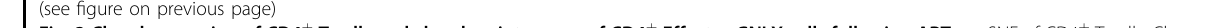
Fig. 3 Clonal expansion of CD4 + T cells and clonal maintenance of CD4 + Effector-GNLY cells following ART. a t -SNE of CD4 + T cells. Clusters are denoted by color labeled with inferred cell types (left) and TCR detection (right). Cells are colored the same in (Fig. 1b). b Bar plots showing the percent of TCR detection in each CD4 + T cell cluster. c The association between the number of CD4 + T cell clones and the number of cells per clonotype. The dashed line separates non-clonal and clonal cells, with the latter identi fi ed by repeated usage of TCRs. LOESS fi tting is labeled as the solid line showing a negative correlation between the two axes. d The distribution of the clone state of CD4 + T cells in each cluster across the three conditions. e Comparison between the fraction of clonal cells in each subset ( X -axis) and percentage of cells with TCRs shared across clusters ( Y -axis). f Developmental transition of CD4 + Effector-GNLY cells with other CD4 + cells quanti fi ed by pairwise STARTRAC-tran indices for each patient ( n = 14). *** P < 0.001, Permutation test. g Top 5 paired V-J usage of TRA/B genes across four healthy donors and 14 chronic HIV-1-infected individuals. h Scatterplots comparing TCR clone frequencies between pre- and post-ART treatment for three participants. The size of the dot corresponds to the number of distinct clonotypes. The clonotypes that are shared between pre- and post-ART are displayed in blue, and those only in TP or ART are in green or orange,